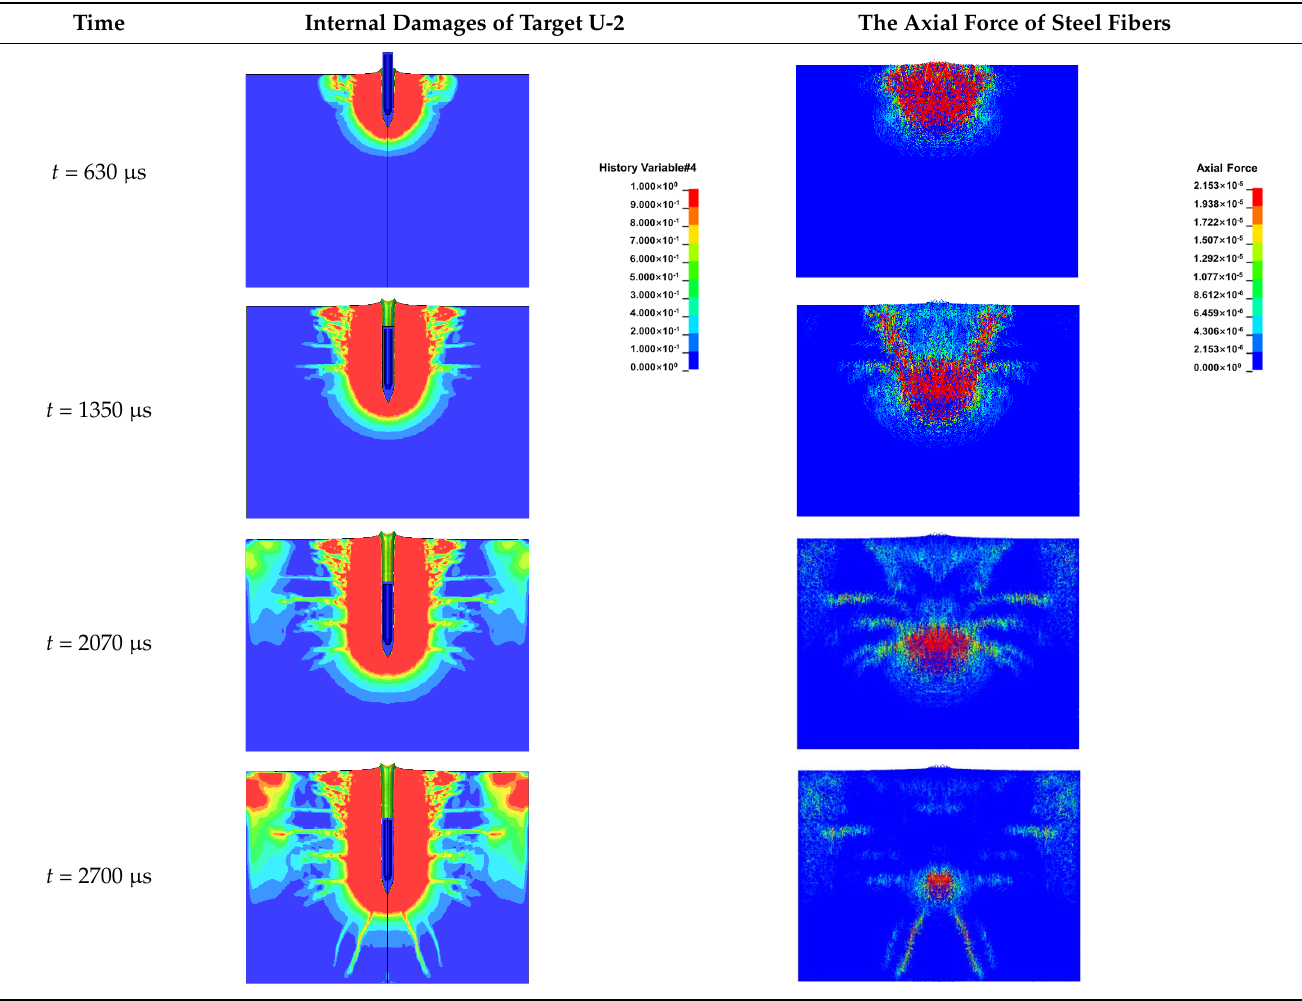
Table 7. Development of internal damages and steel fibers axial force in target U-2.